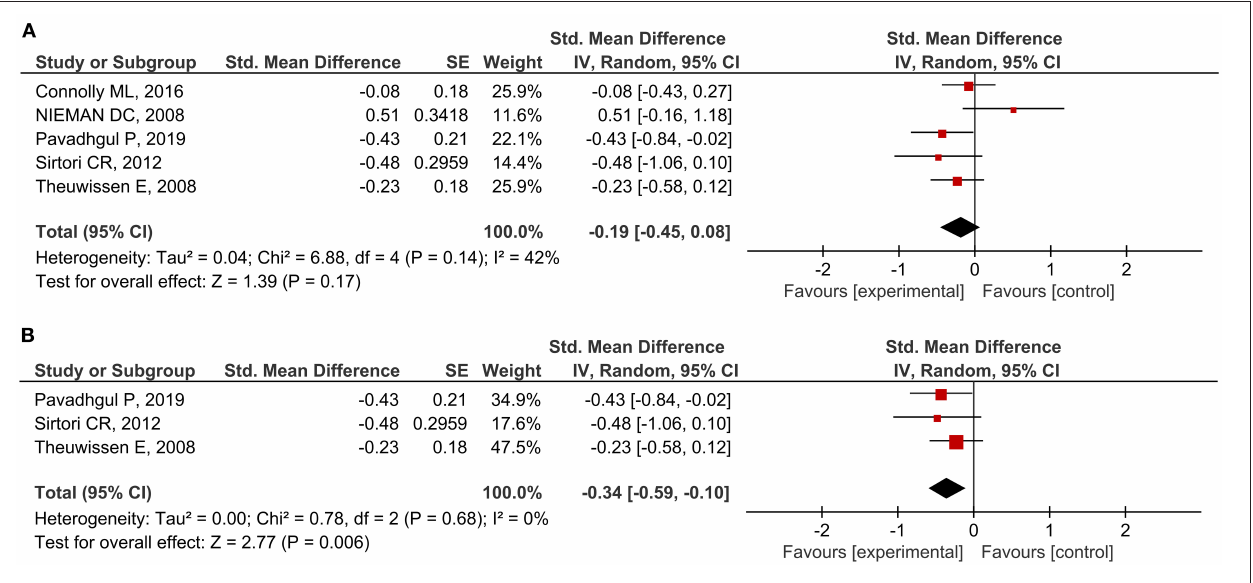
FIGURE 3 | Meta-analysis results of IL-6: (A) all studies, (B) unhealthy subjects in the subgroup based on the basal